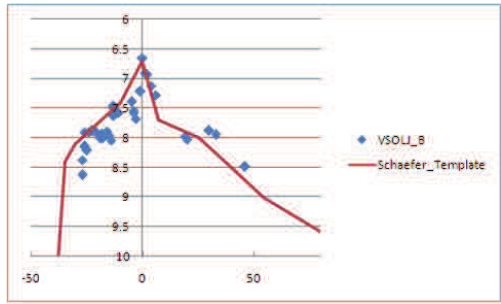
Figure 2: Light curve obtained by VSOLJ members during 2011